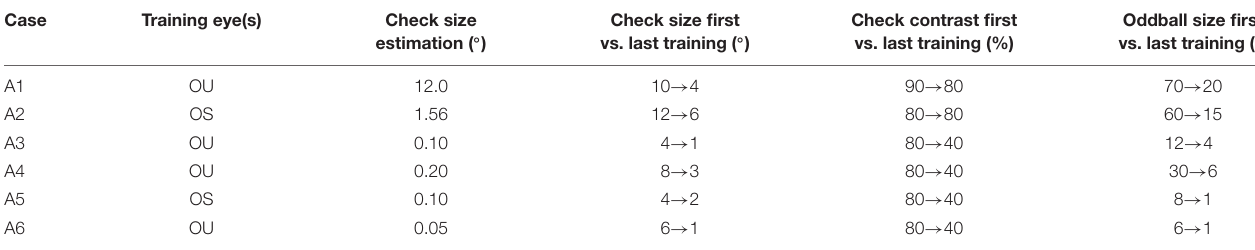
TABLE 2 | Characteristics of checkerboard pattern and oddball stimuli for visual training ( n = 6).